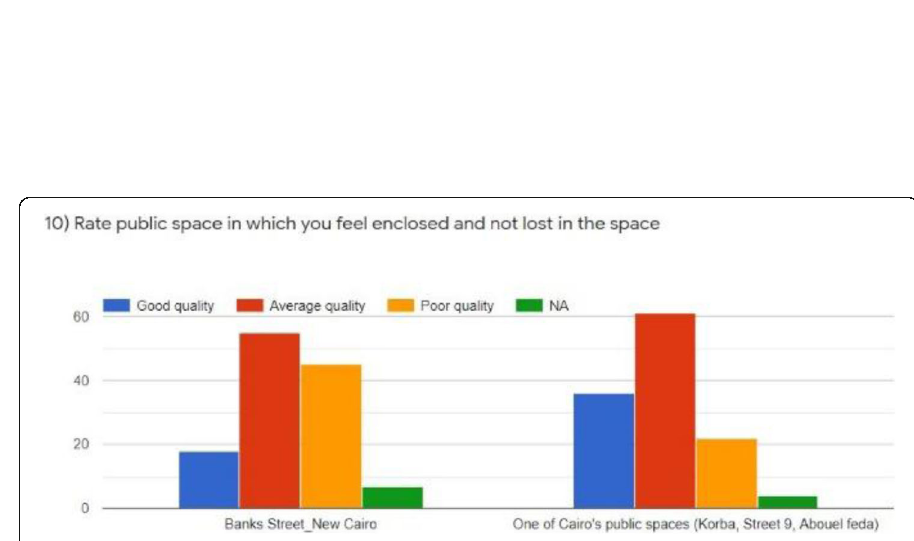
Fig. 22 Enjoying feeling enclosed in space scale (Author)